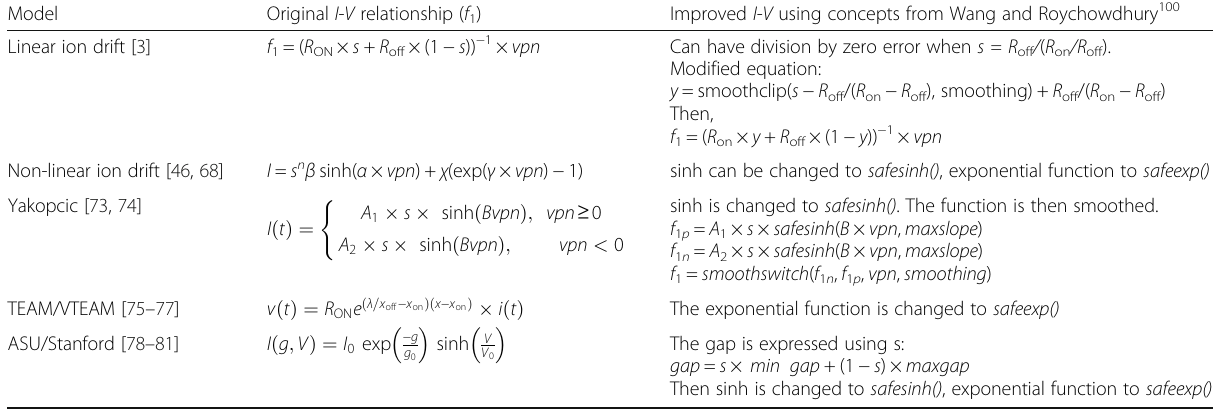
Table 3 Improved I - V relationships of the various models